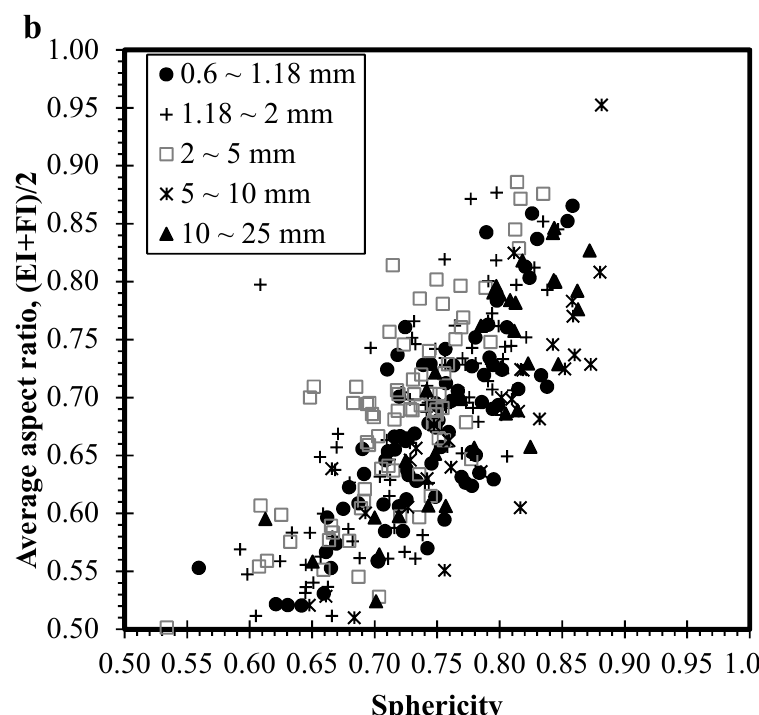
Figure 4. Correlation ( a ) between Flatness Index and Elongation Index where a ≥ b ≥ c represents the major, intermediate, and minor axes, respectively and ( b ) between average aspect ratio and sphericity.